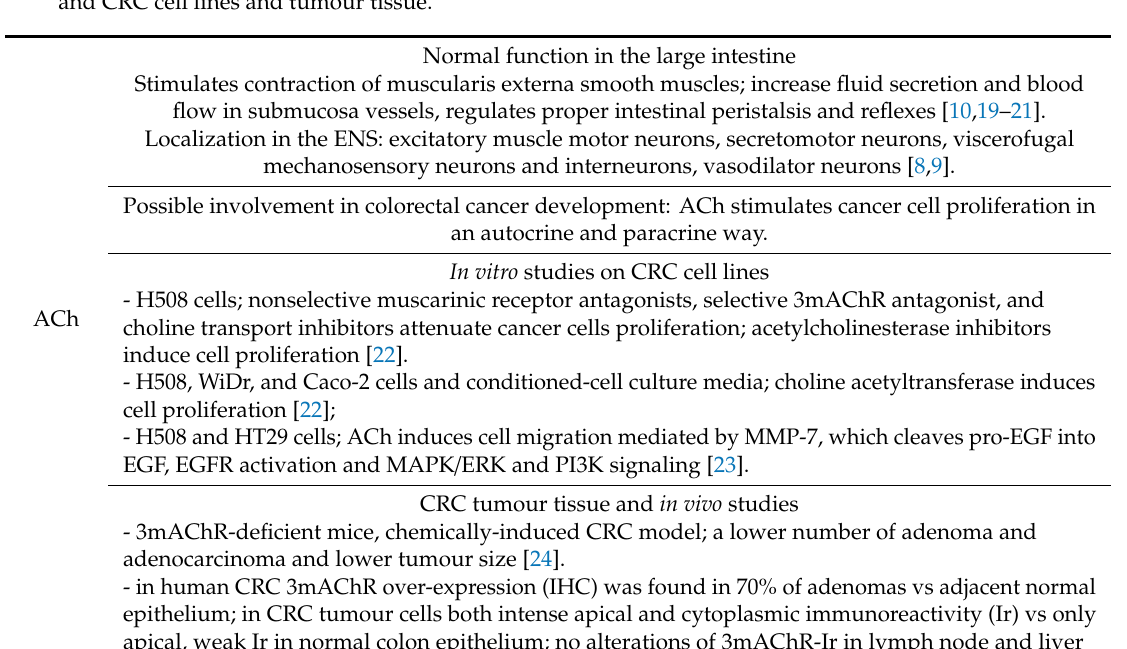
Table 1. Function and localisation of the ENS neurotransmitters in the normal human large intestine and CRC cell lines and tumour